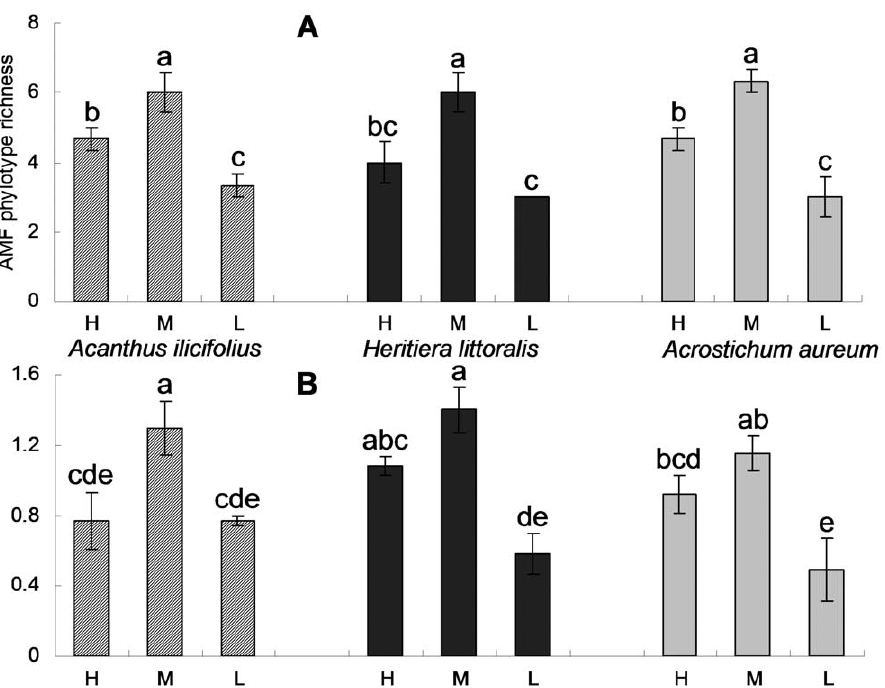
Figure 3. Graphical representation of the AMF (A) phylotype richness and (B) Shannon ’ s index within roots. H, M and L represent the high, middle and low tide level, respectively. Different letters above the columns indicate significant differences across all host species and tide levels at the 0.05 level; mean 6 SE.